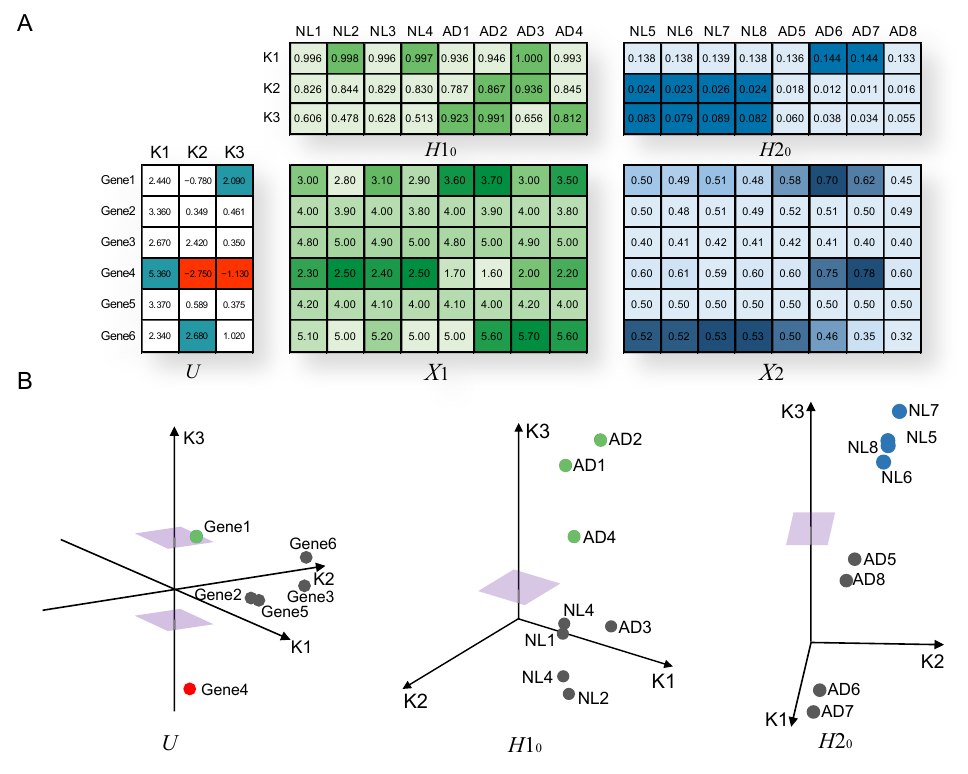
Figure 2. An example of the module construction. ( A ) Result of JDSNMF decomposition. In U , H 1 0 , and H 2 0 , cyan, green, and blue elements were larger than positive thresholds, and in U , H 1 0 , and H 2 0 , red elements were smaller than a negative threshold in U . ( B ) Genes and samples are coordinated for each axis, each of which represents a module. In U , H 1 0 , and H 2 0 , cyan, green, and blue elements are larger than positive thresholds, and in U , red elements are smaller than a negative threshold. Purple squares represent thresholds of the K3